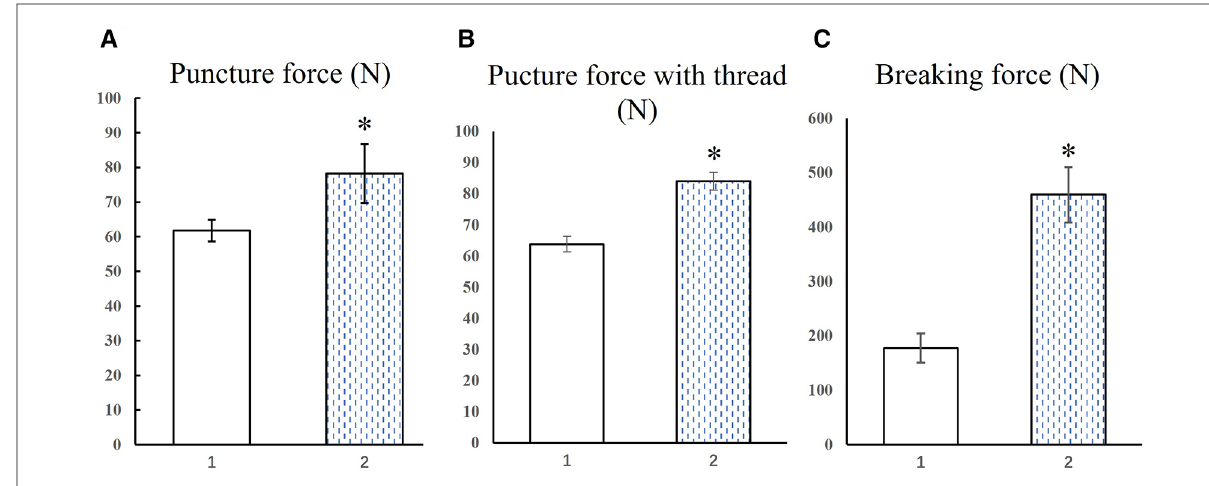
FIGURE 4 Needle with intact tip (1), needle with broken tip (2), * р